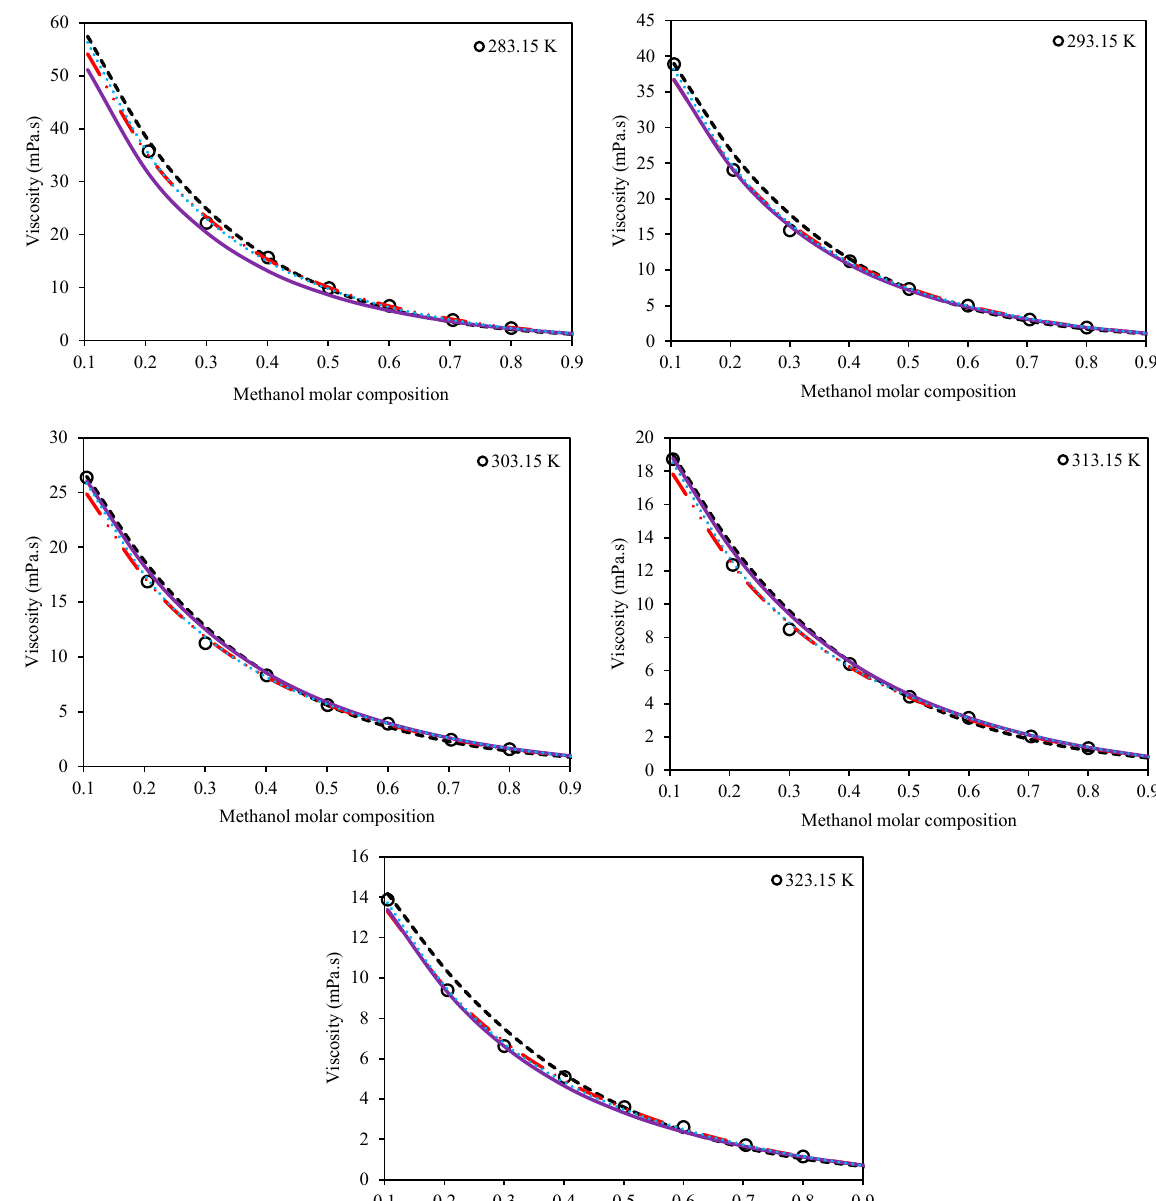
Figure 3. Comparison of the behavior of the Grunberg–Nissan [20], Jouyban–Acree [21], McAllister [22], and Preferential Solvation [23,24] models with respect to the experimental trend for the system of Ethaline (1 ChCl:2 ethylene glycol) + methanol at various temperatures and at a pressure of 100 kPa. (Grunberg–Nissan (---), Jouyban–Acree ( ― ••), McAllister ( ― ), Preferential Solvation (•••), Experimental data (o)).